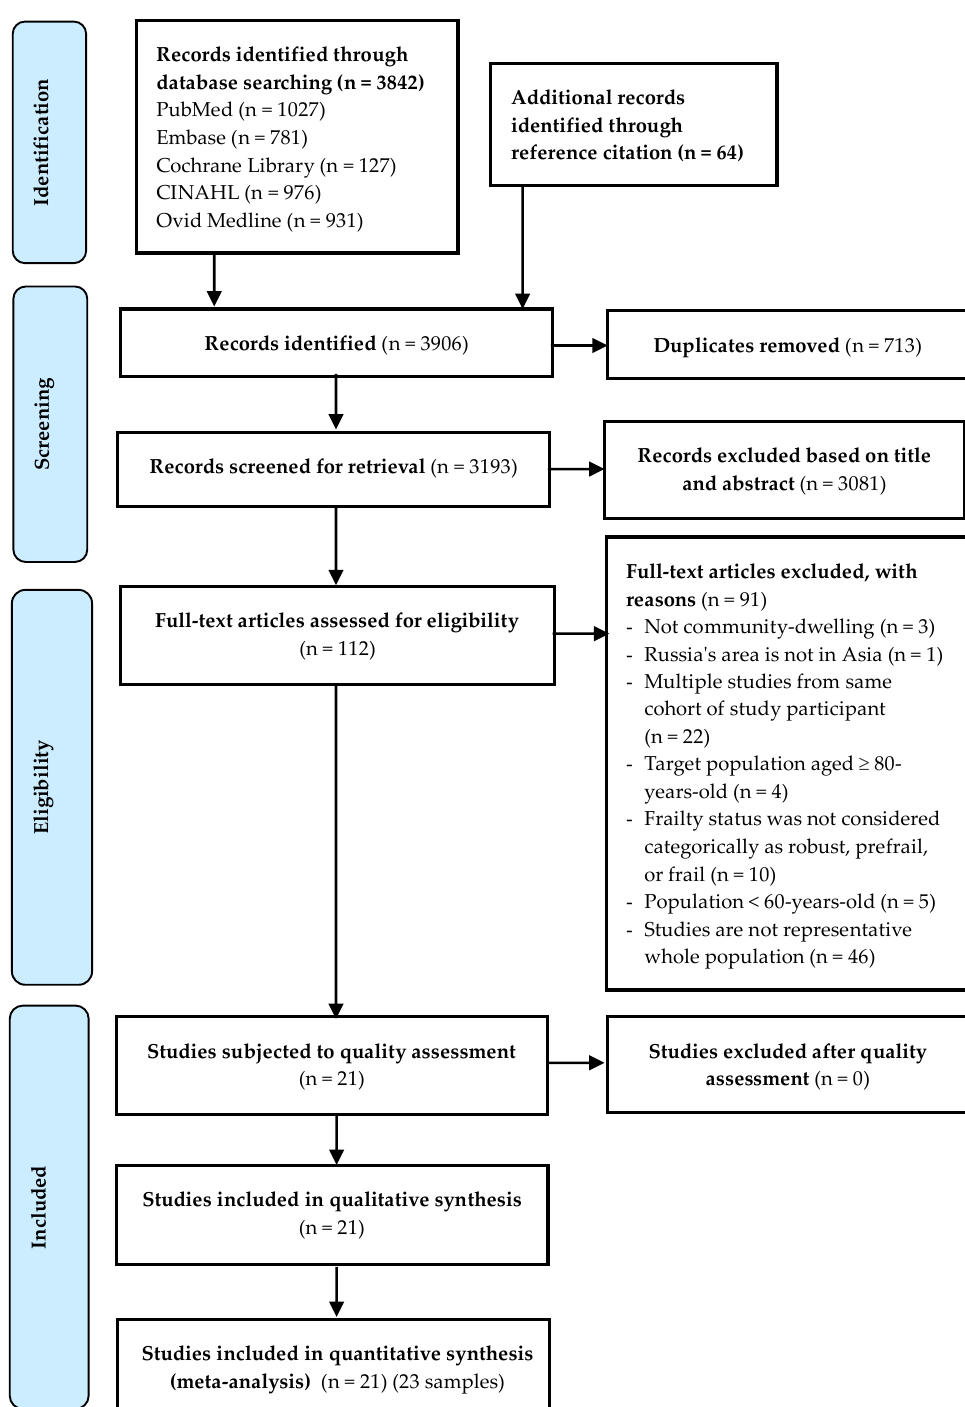
Figure 1. PRISMA flow diagram of the Study Selection Process.